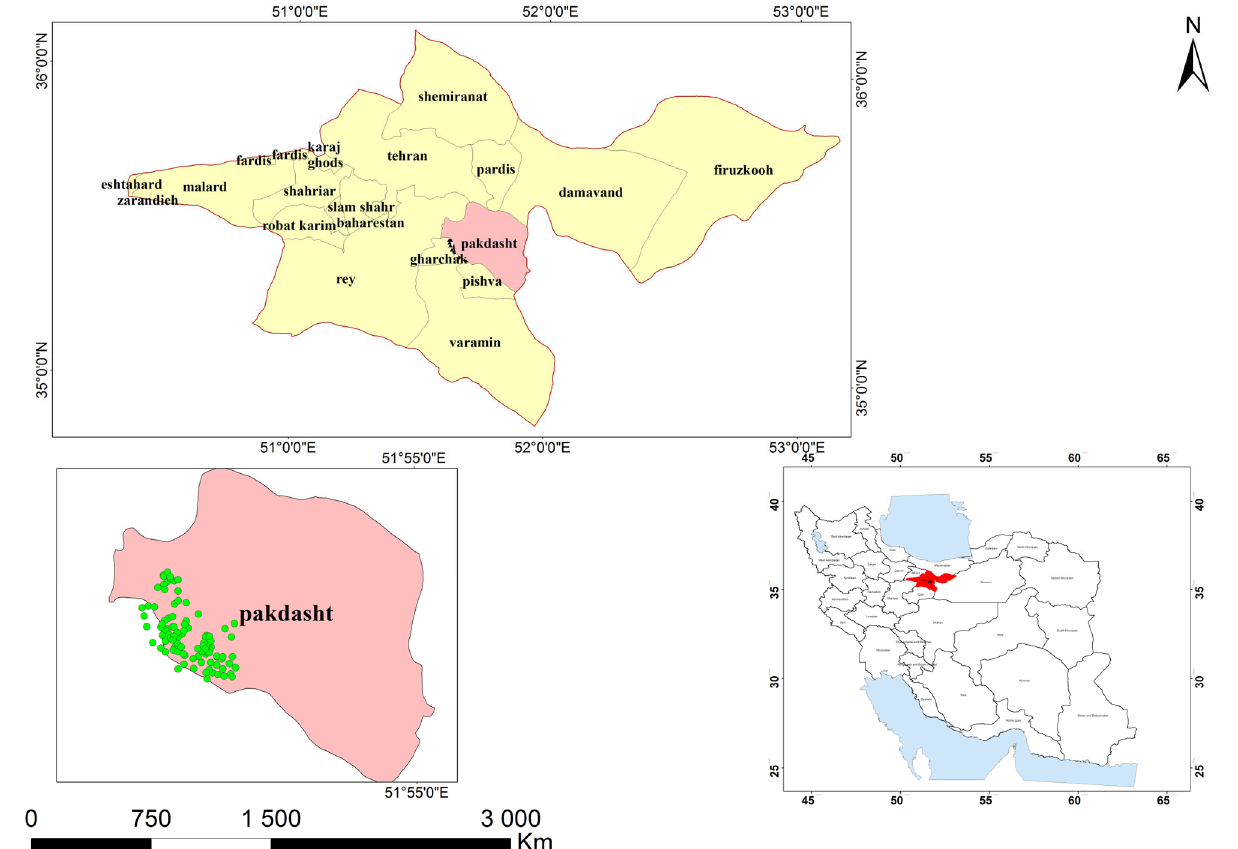
Figure 1. Iran country map and the location of Tehran province and Pakdasht. (The green dots show the exact location of the studied fields).